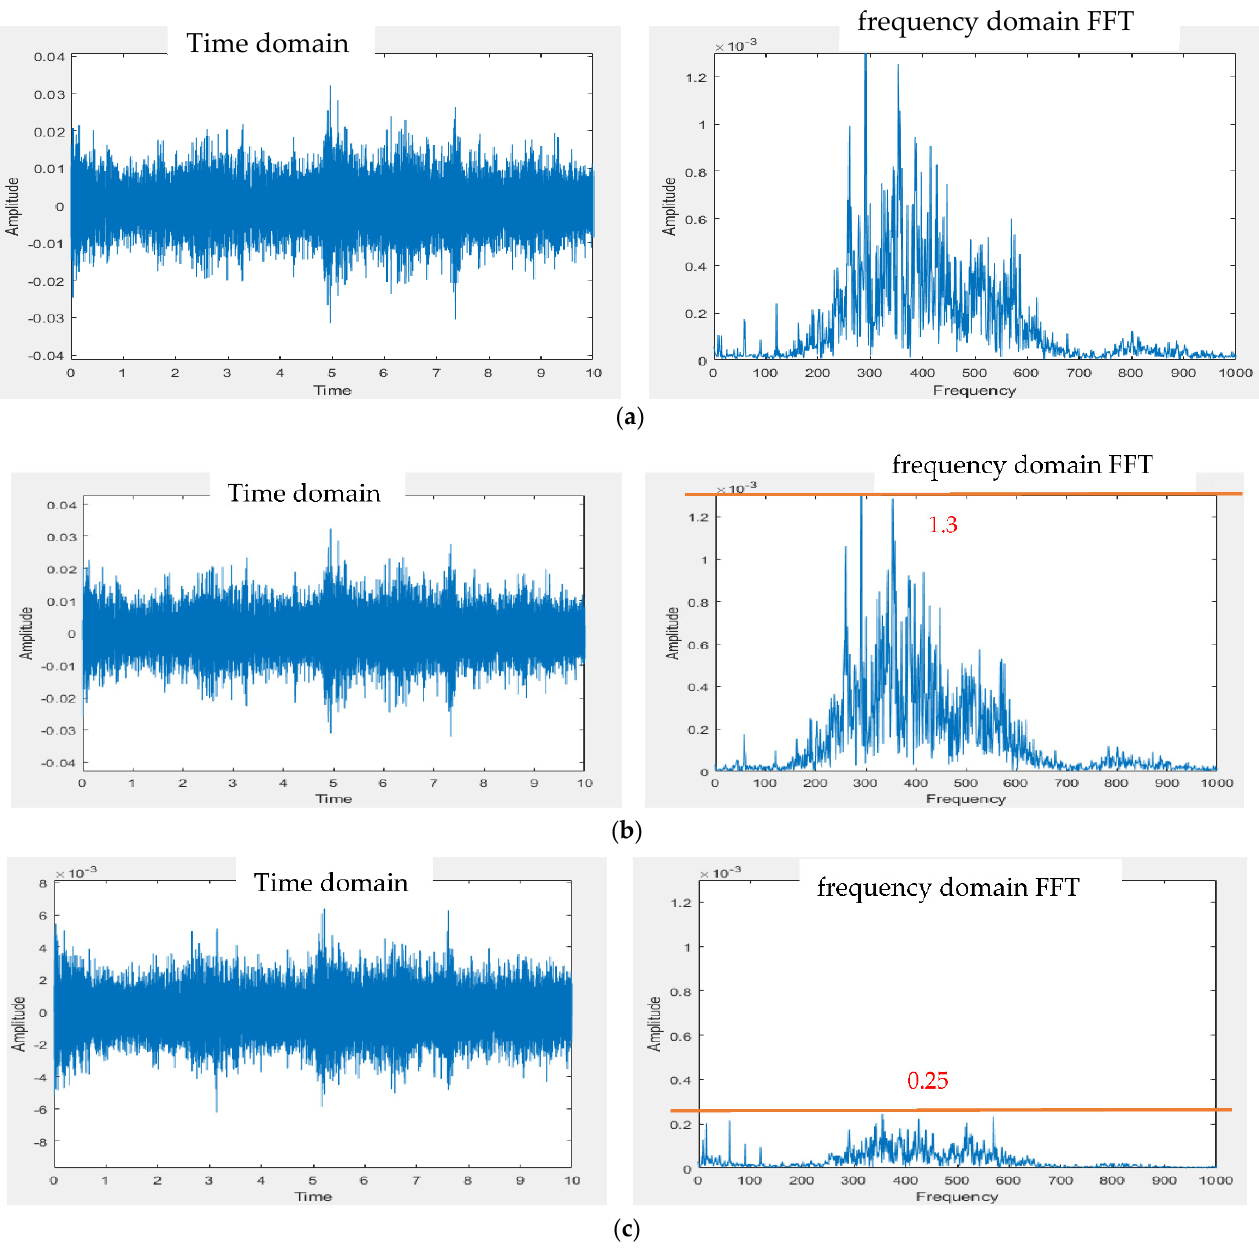
Figure 12. Noise reduction effect for ward construction noise. ( a ) Signal waveform and FFT spec- trum measured by mic 1. ( b ) Signal waveform and FFT spectrum measured by mic 2. ( c ) Signal waveform and FFT spectrum after noise reduction